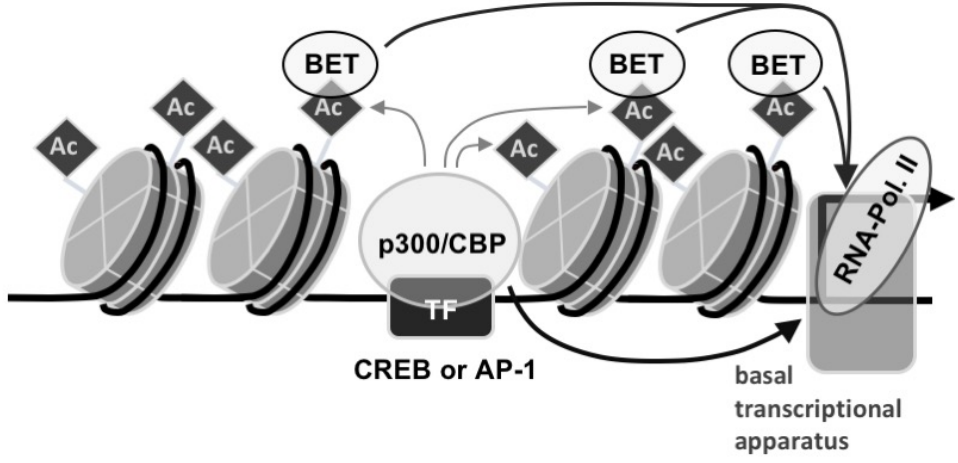
Figure 7. Regulation of epigenetic gene transcription by CBP/p300 and BET bromodomain proteins. Transcription factors such as CREB and AP-1 bind to specific DNA binding sites and recruit the coactivator and histone acetyltransferase proteins CBP and p300. These proteins catalyze the acetylation of histones, and by this means generate an open chromatin architecture. CBP/p300 also acts as a bridge to the basal transcriptional apparatus to support transcriptional activation. BET proteins bind to acetylated lysine residues in histone proteins and recruit coactivators and epigenetic regulators required for